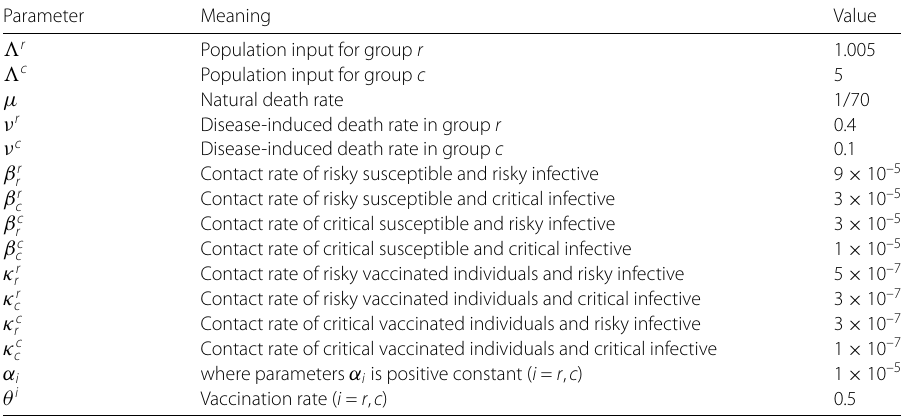
Vaccination rate ( i = r , c )